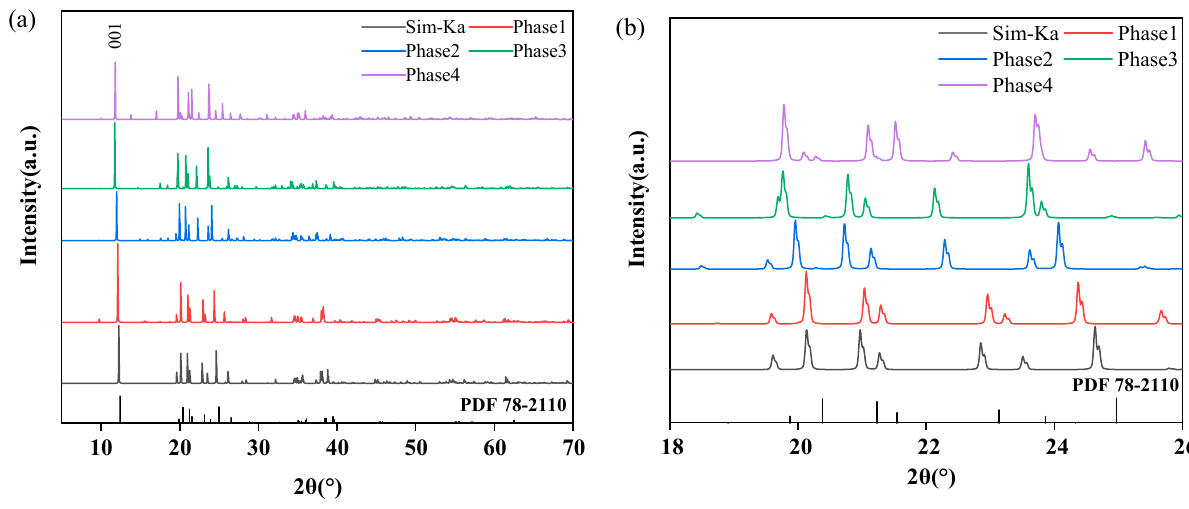
Figure 6. ( a ) The simulated XRD patterns of Sim-Ka, Phase 1, Phase 2, Phase 3, and Phase 4; ( b ) partial amplification of simulated XRD patterns of Sim-Ka, Phase 1, Phase 2, Phase 3, and Phase 4 in the range of θ = 18–26°.